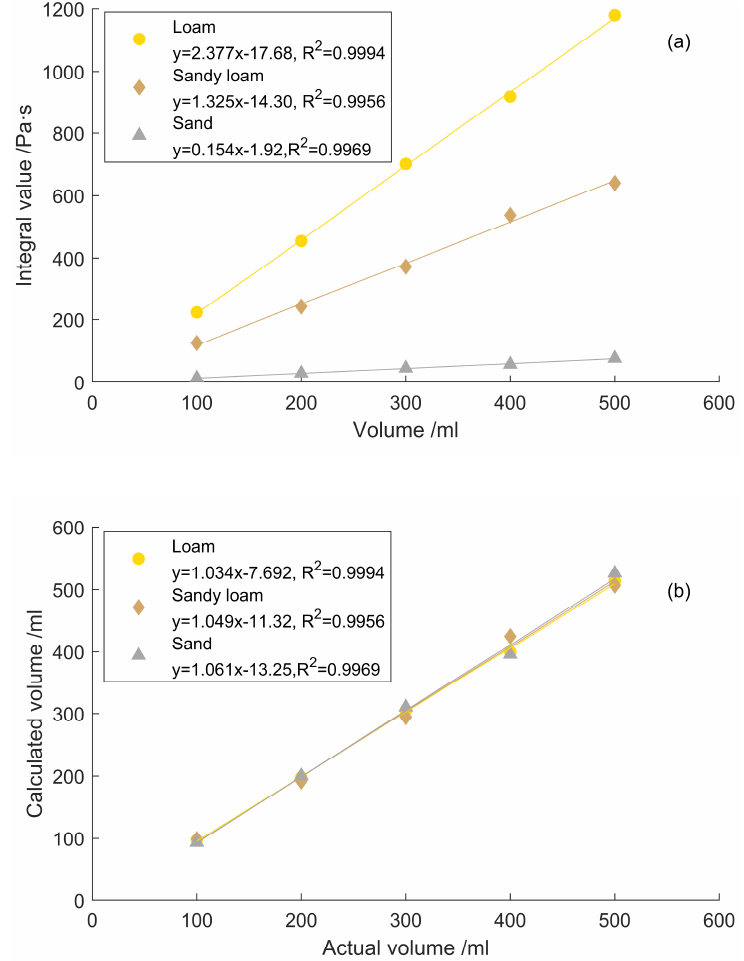
Figure 6. Relationship between theoretical and actual pumping pressure values: ( a ) integrated val‑ ues of the differential pressure decay curves for the three soil porous media, and ( b ) verification of the theoretical and actual pumped gas volumes calculated using Equation (10).